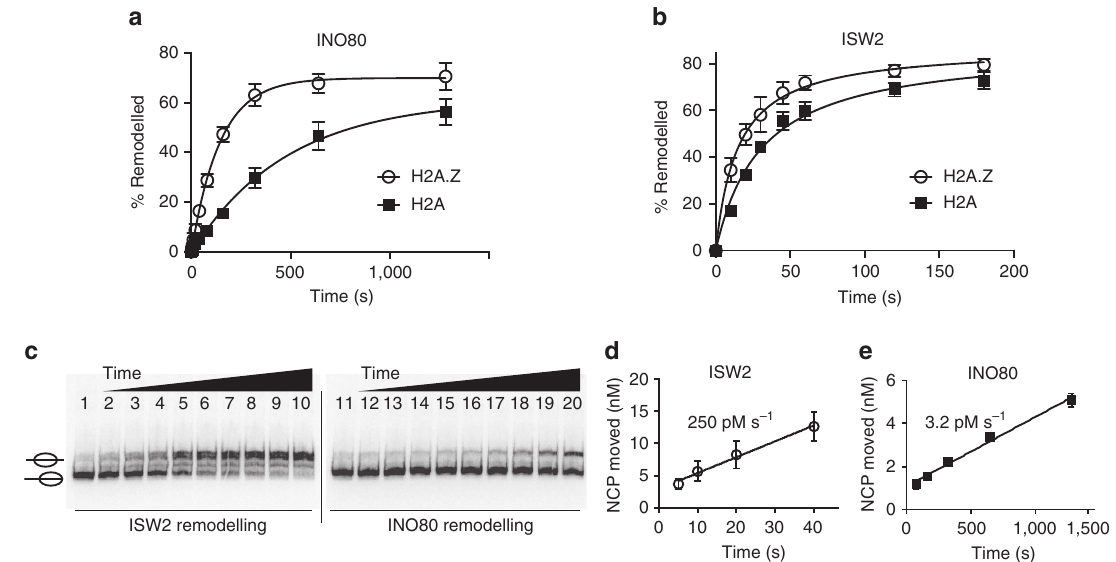
Figure 6 | INO80 preferentially mobilizes H2A.Z over H2A nucleosomes. ( a , b ) The rates of nucleosome movement by ( a ) INO80 and ( b ) ISW2 with H2A.Z and H2A nucleosomes as determined by electrophoretic-mobility shift assay in native gels (Supplementary Fig. 6a). The fractions (%) of nucleosomes moved were plotted versus time to determine the rates of H2A.Z versus H2A nucleosome movement. ( c ) The efficiencies of ISW2 (lanes 2– 10) and INO80 (lanes 11–20) for mobilizing nucleosomes were determined by the rates with which they repositioned H2A-containing nucleosomes. End- positioned (70N0) nucleosomes were completely bound with ISW2 or INO80 and remodelled with 80 m M ATP at 18 (cid:2) C for 0, 5, 10, 20, 40, 80, 160, 320, 640 and 1,280s. ( d , e ) The amounts of nucleosomes moved were plotted versus time to determine the initial rates of nucleosome movement by ISW2 ( d ) and INO80 ( e ). NCP is for nucleosome core particles. Error bars represent standard deviation of the mean (s.d.) calculated from three technical replicates.